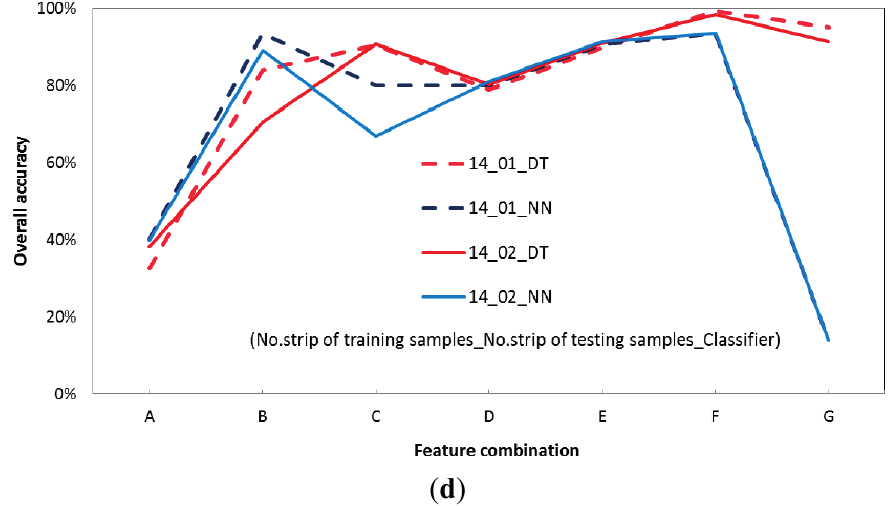
Figure 10. Overall accuracy of feature combination in terms of data from different flight missions using the decision tree (DT) and neural network (NN) classifiers: ( a ) training samples (01), testing samples (11 or 14). ( b ) Training samples (02), testing samples (11 or 14). ( c ) Training samples (11), testing samples (01 or 02). ( d ) Training samples (14), testing samples (01 or 02). Labels on the x-axes are as follows. A:{ Linearized Amplitude , and Width }, B: { Linearized Amplitude , Width , and dZ }, C:{ Linearized Amplitude , Width , RSS h , and dZ }, D:{ γ and FW cv }, E:{ γ , FW cv , and dZ }, F:{ γ , FW cv , RSS h , and dZ }, G:{ Linearized Amplitude , Width , γ , FW cv , RSS h , and dZ